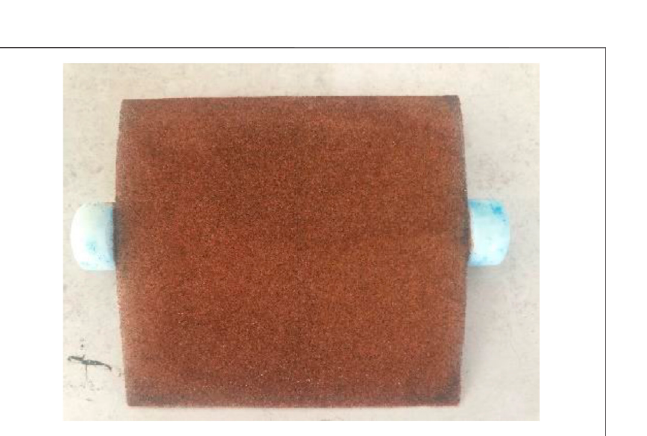
FIGURE 4 | Cascade roughness treatment.